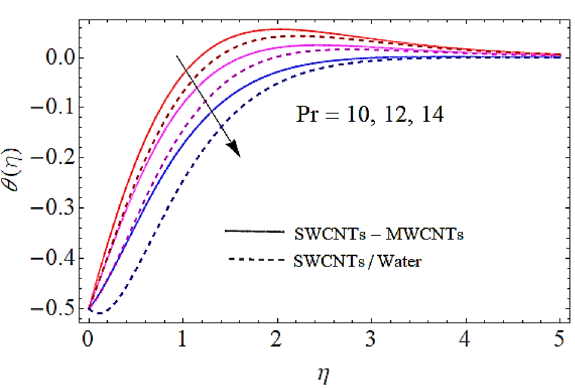
Figure 8. Thermal profiles versus Pr when M = 0.5, (cid:31) = 0.3, φ 1 = φ 2 = 0.02, K = 0.7, R H = 0.6